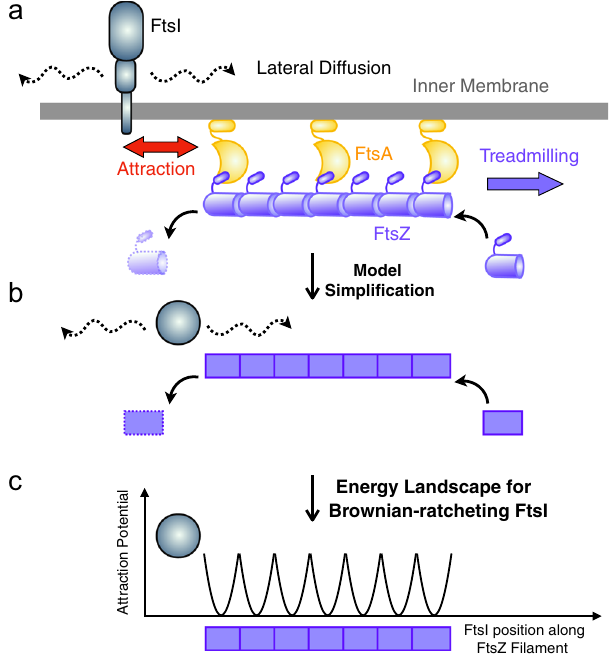
Fig. 1 Model description. a Schematic representation of an sPG synthase complex ’ s interaction with FtsZ treadmilling. FtsZ resides in the cytoplasm. FtsI is a transmembrane protein that does not dissociate from the membrane even when it dissociates from FstZ . b Model simpli fi cation of FtsZ – FtsI interaction at the septum. The FtsZ fi lament (purple) undergoes treadmilling by dissociating an FtsZ subunit from the left end and associating new ones on the right end. While FtsI (gray) intrinsically diffuses around, it has a binding af fi nity to FtsZ subunits . c Schematics of FtsZ – FtsI binding potentials. Here, the binding potential is assumed to be harmonic and short-ranged (~5 nm), which is about the size of an individual FtsZ subunit. Note that there is no energy barrier for FtsI to bind to FtsZ, because the binding potential is attractive. Once FtsI binds to an FtsZ subunit, however, the binding potential presents an energetic barrier preventing FtsI from diffusing